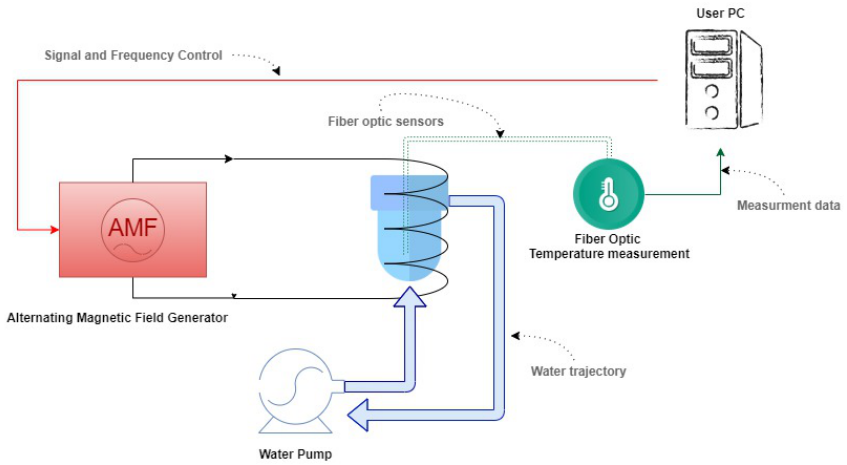
Figure 1. Hyperthermia system